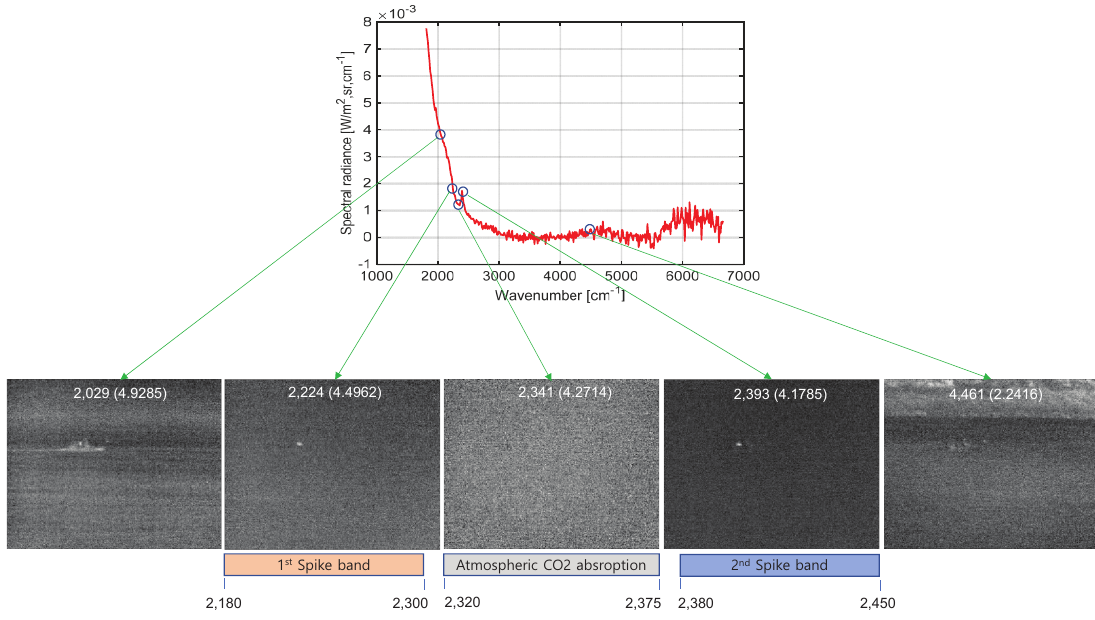
Figure 11. Analysis of spectral band ranges for ship detection by visualizing corresponding band